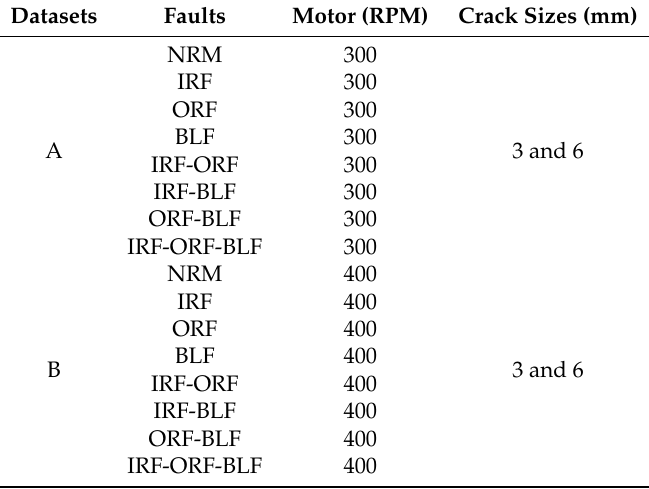
Table 2. Ulsan Industrial Artificial Intelligence (UIAI) Lab Acoustic Emission Bearing